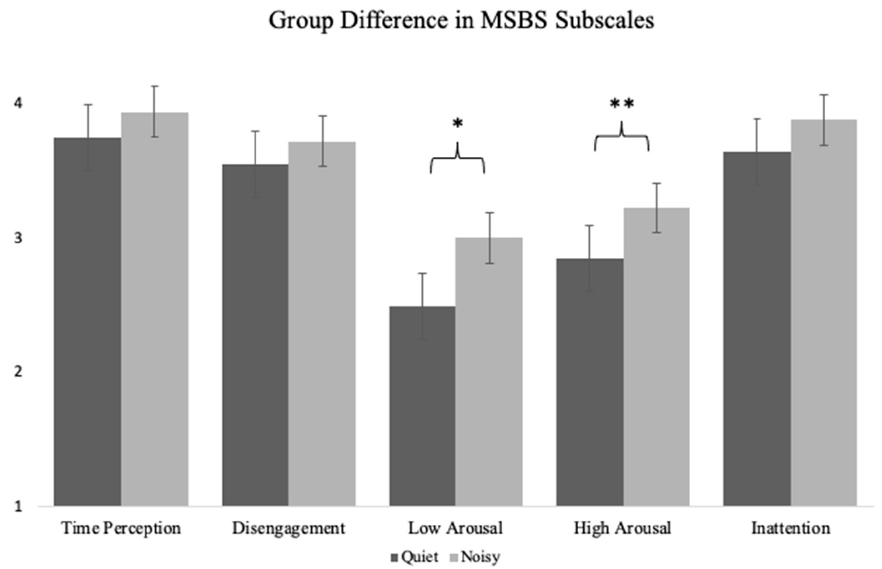
Figure 2. Difference in Multidimensional State Boredom Scale (MSBS) subscales for people in noisier or quieter environments. * p < 0.05, ** p < 0.01. Error bars represent standard error.